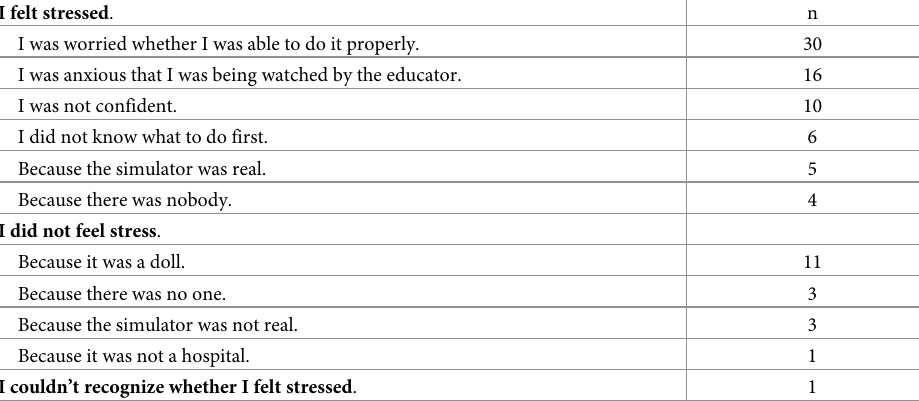
Table 2. Students’ reports on stress during the simulation (Multiple answers